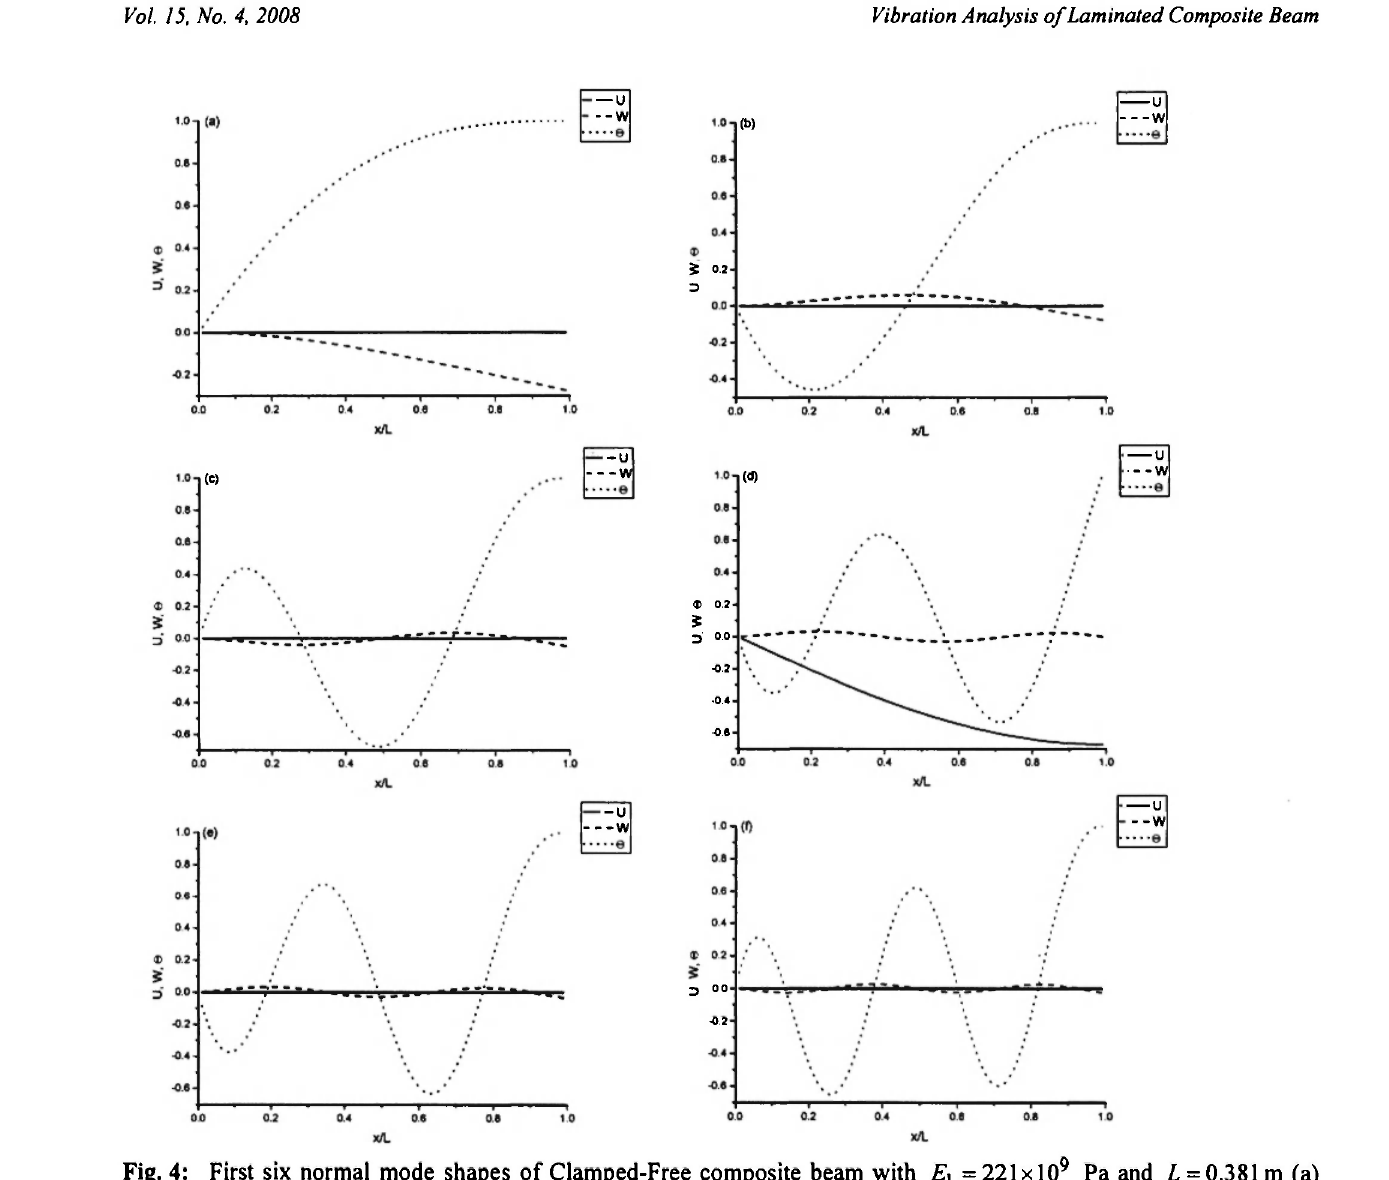
Fig. 4: First six normal mode shapes of Clamped-Free composite beam with Ej =221 χ 10 9 Pa and L = 0.381 m (a) mode 1; (b) mode 2; (c) mode 3; (d) mode 4; (e) mode 5; (f) mode